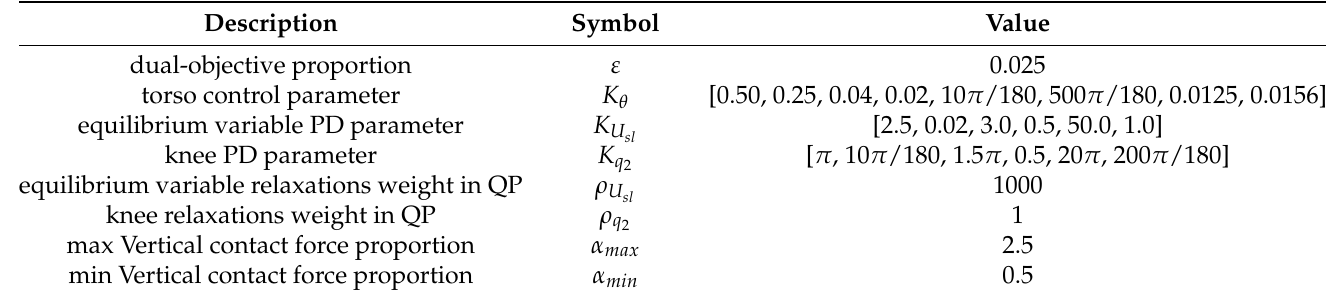
Figure 5. Snapshots of sliding on uneven terrain: ( a ) sliding from the bottom to the uphill, ( b ) sliding from the uphill to the flat-top, ( c ) sliding from the flat-top to the downhill, ( d ) sliding from the downhill to the bottom, ( e ) sliding having stopped. Table 2. Control parameters in sliding.